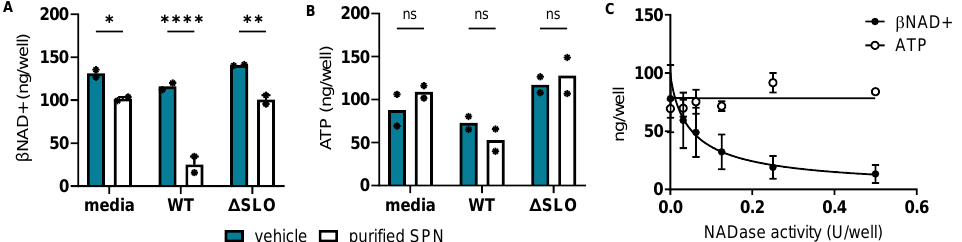
Figure 2. SPN depletes SkMC βNAD+. ( A , B ) Cultured SkMCs were treated with an 8-fold dilution of media (Todd Hewitt broth) or culture supernatants from either wild-type (WT) M5 GAS (SLO pos /SPN inactive ) or the SLO-deficient ( ∆ SLO) isogenic mutant (SLO neg /SPN inactive ) in the absence (closed bars) or presence (open bars) of purified, enzymatically-active SPN (0.03 U). Bars represent the means of n = 2 independent experiments shown as symbols Significance was determined by ANOVA followed by Sidak’s multiple comparison * p ≤ 0.02; ** p ≤ 0.005; **** p ≤ 0.0001; ns = not significant. ( C ) Cultured human SkMCs were exposed to increasing concentrations of purified SPN specified in NADase units per well (U/well). Symbols represent the means of n = 3 (βNAD+) or n = 2 (ATP) independent experiments. Error bars represent SEM. The 50% effective concentration (EC50) ± 95% CI was determined by non-linear regression. EC50 = 0.05 ± 0.05 U/well for βNAD+. EC50 was ambiguous for ATP data.